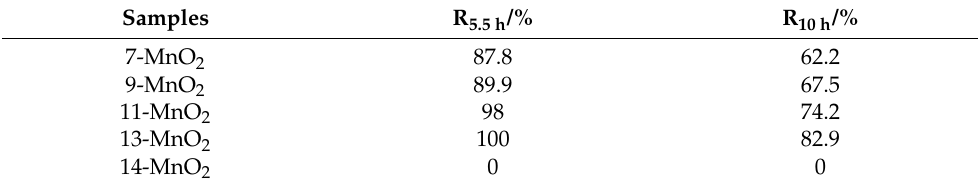
Table 1. List of R 5.5 h and R 10 h for each catalyst. Samples R 5.5 h